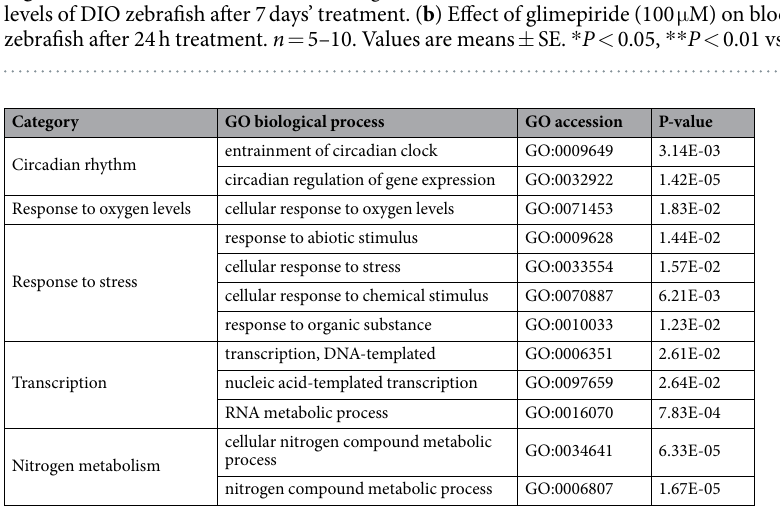
Table 1. Gene Ontology (GO) Enrichment Analysis of altered genes categorized by biological